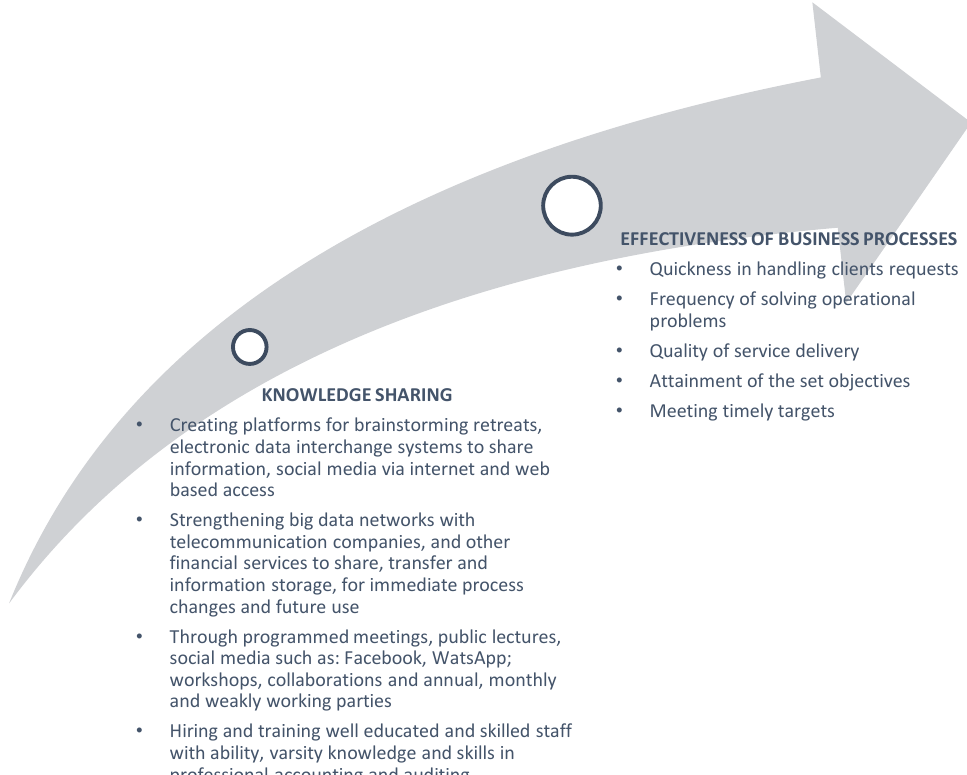
EFFECTIVENESSOF